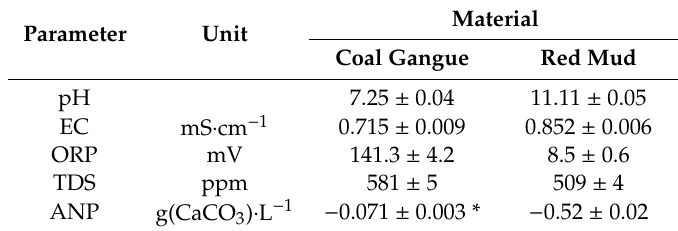
Table 4. The shake extraction indices of coal gangue and red mud (mean ± SD, n = 3). Parameter